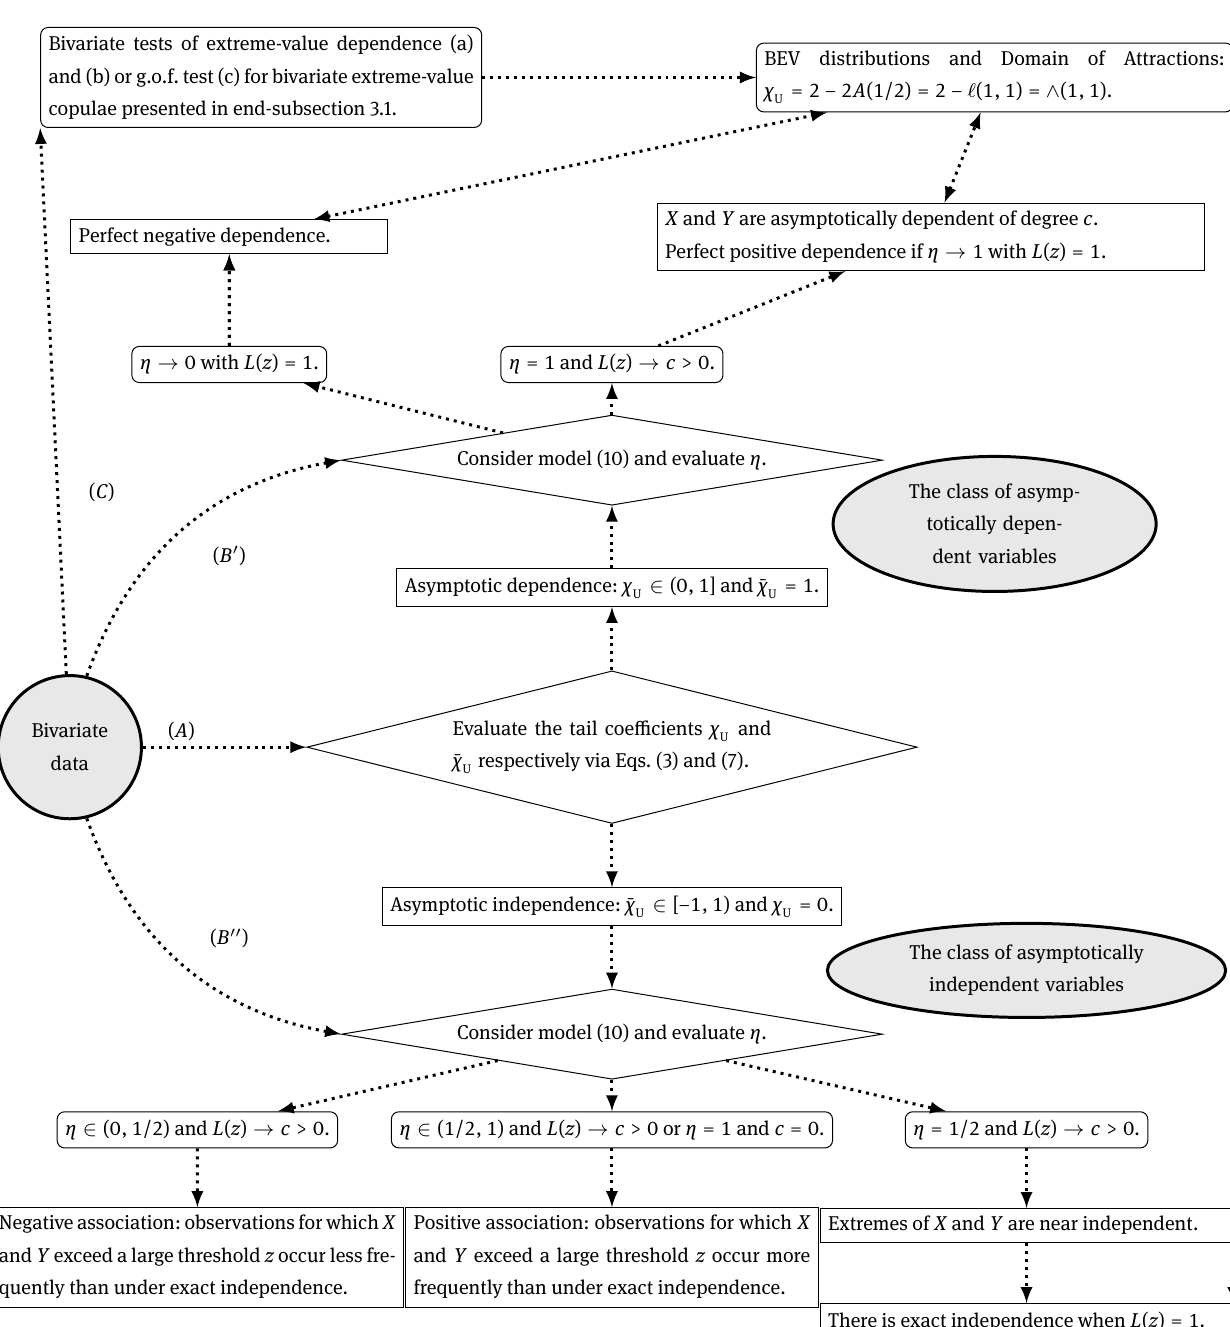
block maxima, hydrologists tend to jointly model flood characteristics with the component-wise maxima, i.e. a BEV distribution, without always checking first if ¯ χ characterized by quantities given in the following